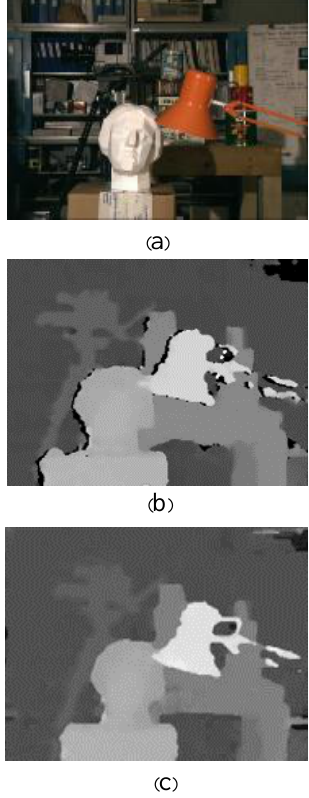
Figure 4. Middlebury Tsukuba Dataset: (a) original left image, (b) disparity image from the implemented semi-global dense matching and (c) disparity image after applying the proposed